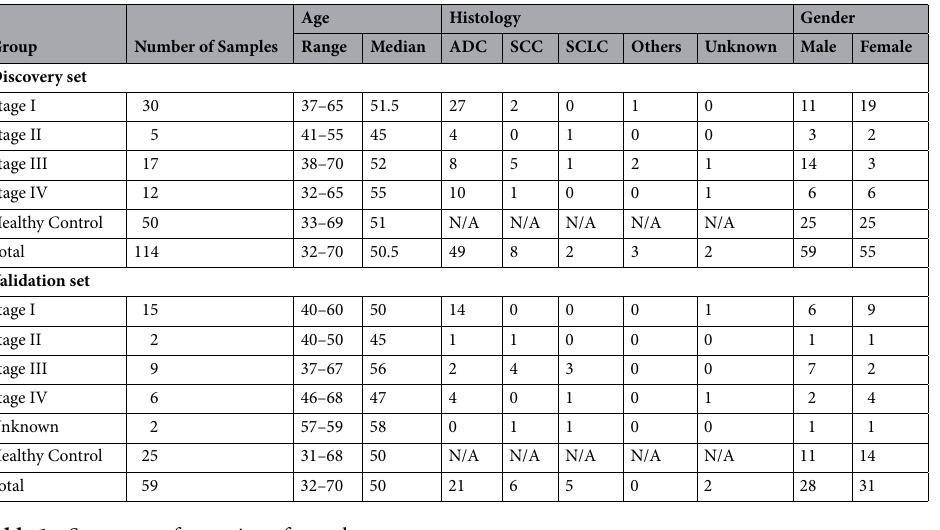
Table 1. Summary of grouping of